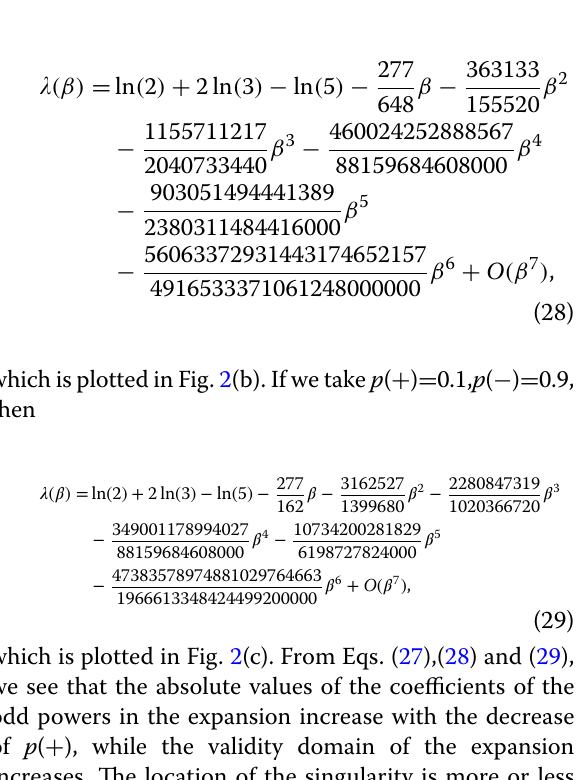
) 0.4, p ( ) 0.6; (c) p ( ) 0.1, p ( ) 0.9; (d) For + = − = + = − =